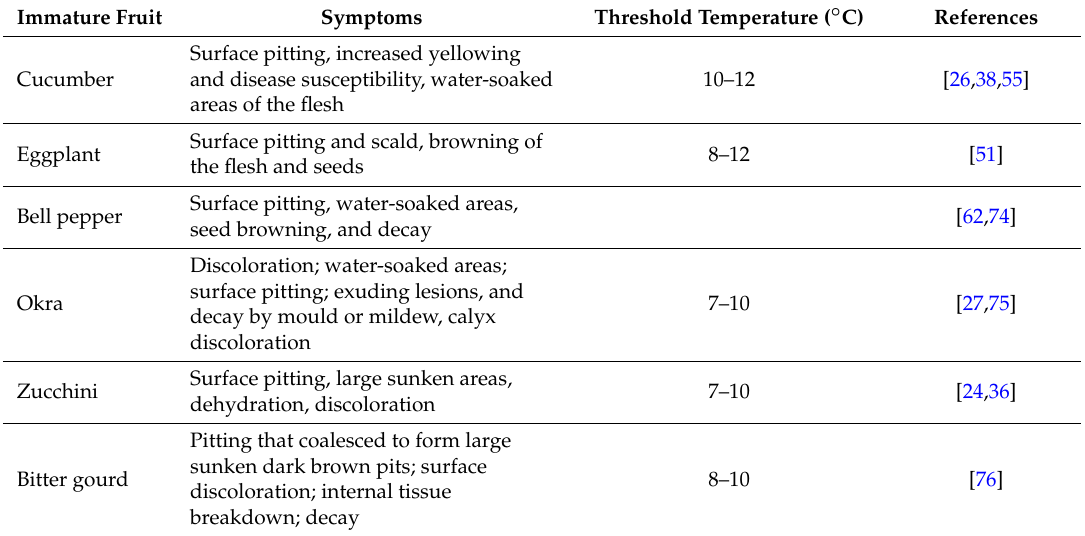
Table 1. Chilling injury symptoms in some immature